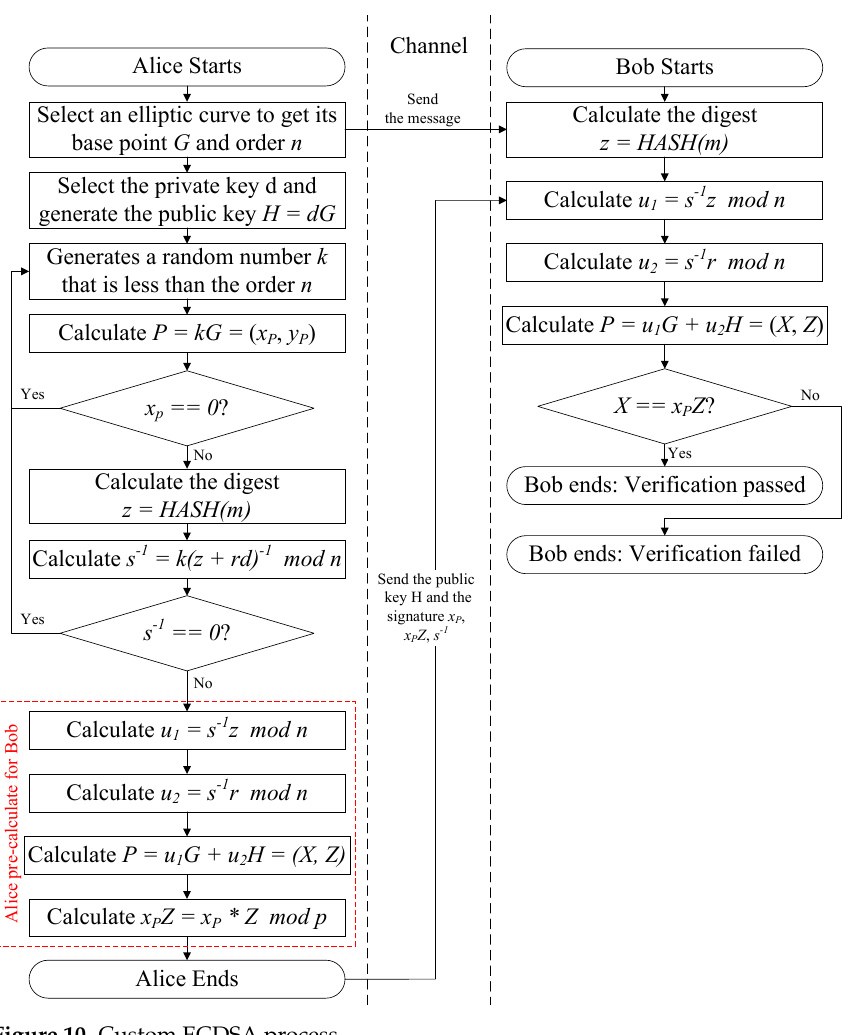
Figure 10. Custom ECDSA